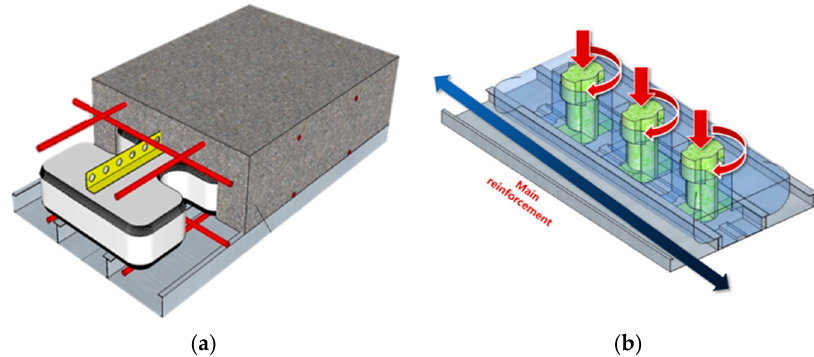
Figure 3. Description of the voided slab system: ( a ) Schematic of the voided slab system, ( b ) Anchoring mechanism of the voided slab system.